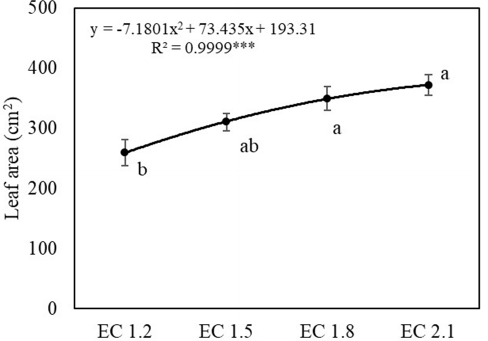
Figure 2. Effect of electrical conductivity (EC; 1.2, 1.5, 1.8, or 2.1 dS·m − ) of the nutrient solution on leaf area of arugula measured 28 days after transplanting into a nutrient-film technique hydro- ponic system. Data points with different letters are significantly different according to Tukey’s test ( α = 0.05). Error bars represent the standard errors ( n = 16). *** indicates significance at P of 0.001.